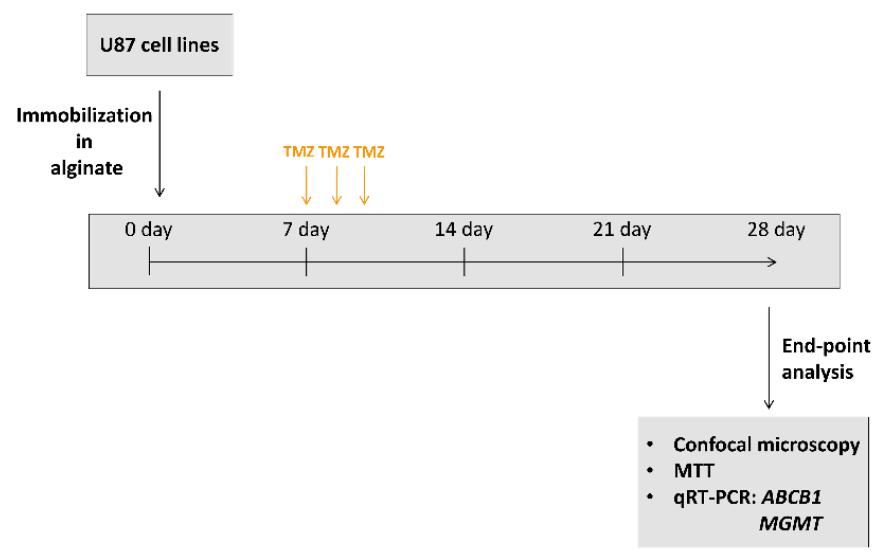
Figure 1. Treatment schedule in long-term 2D and 3D cell cultures.